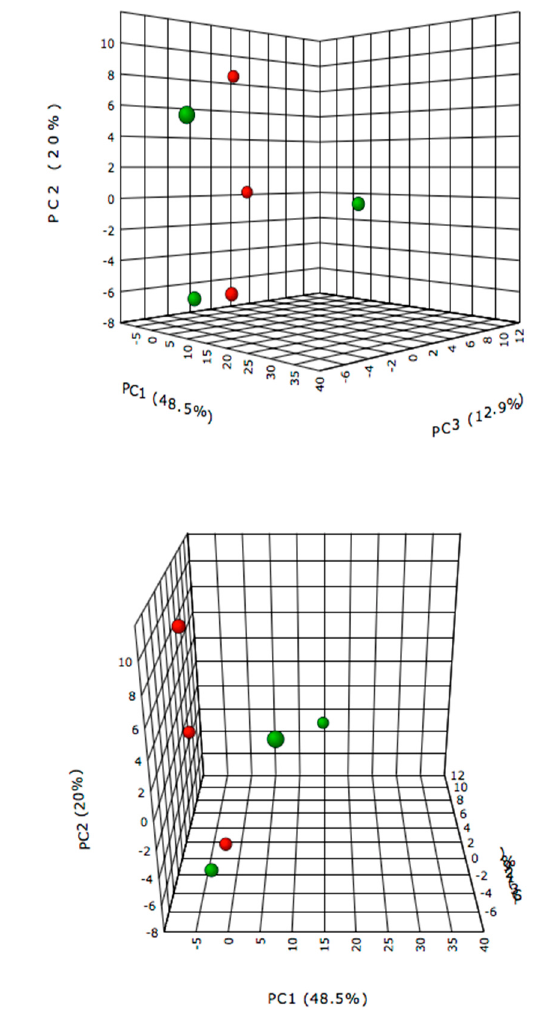
Figure 3. PCA samples amended with vermicompost group vs. control samples.